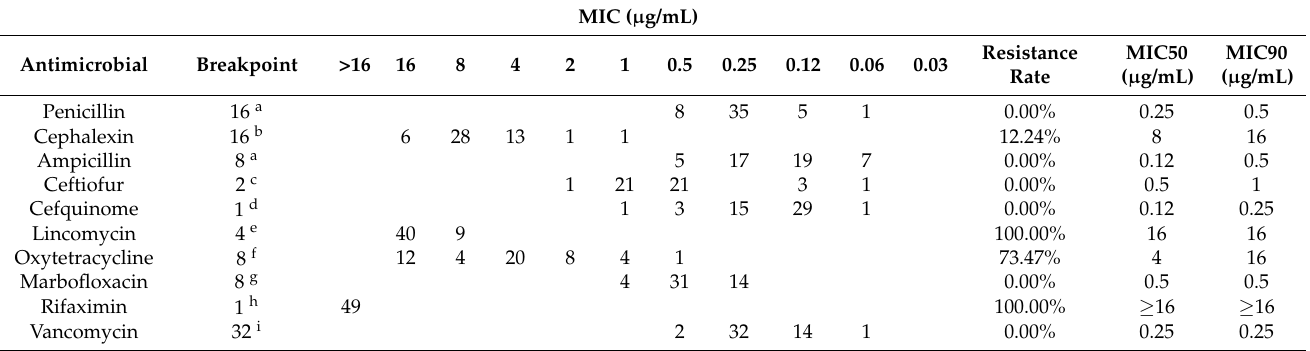
Table 4. Number of isolates at each MIC value of antimicrobial agents against L. garvieae. MIC( μ g/mL ）